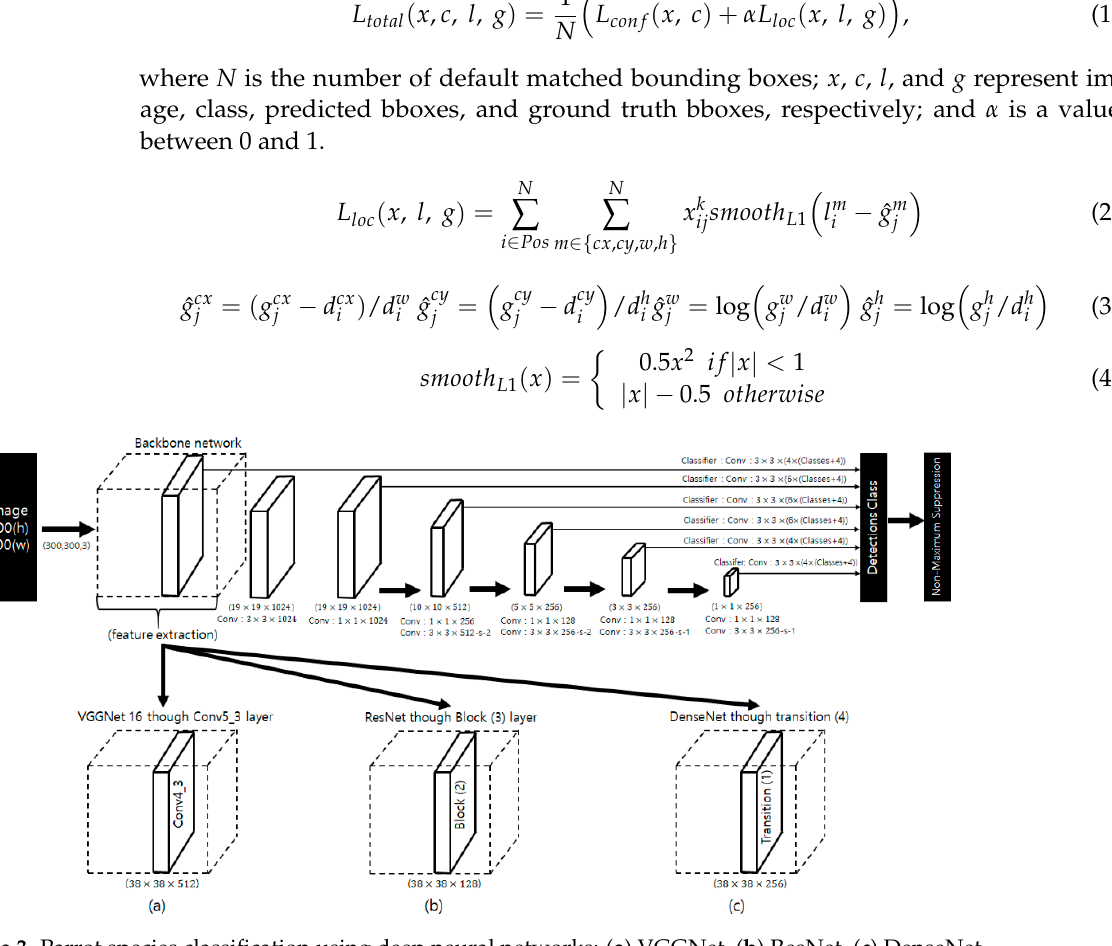
Figure 3. Parrot species classification using deep neural networks: ( a ) VGGNet, ( b ) ResNet, ( c ) DenseNet. Table 3. Model specification of VGGNet based on SSD architecture.